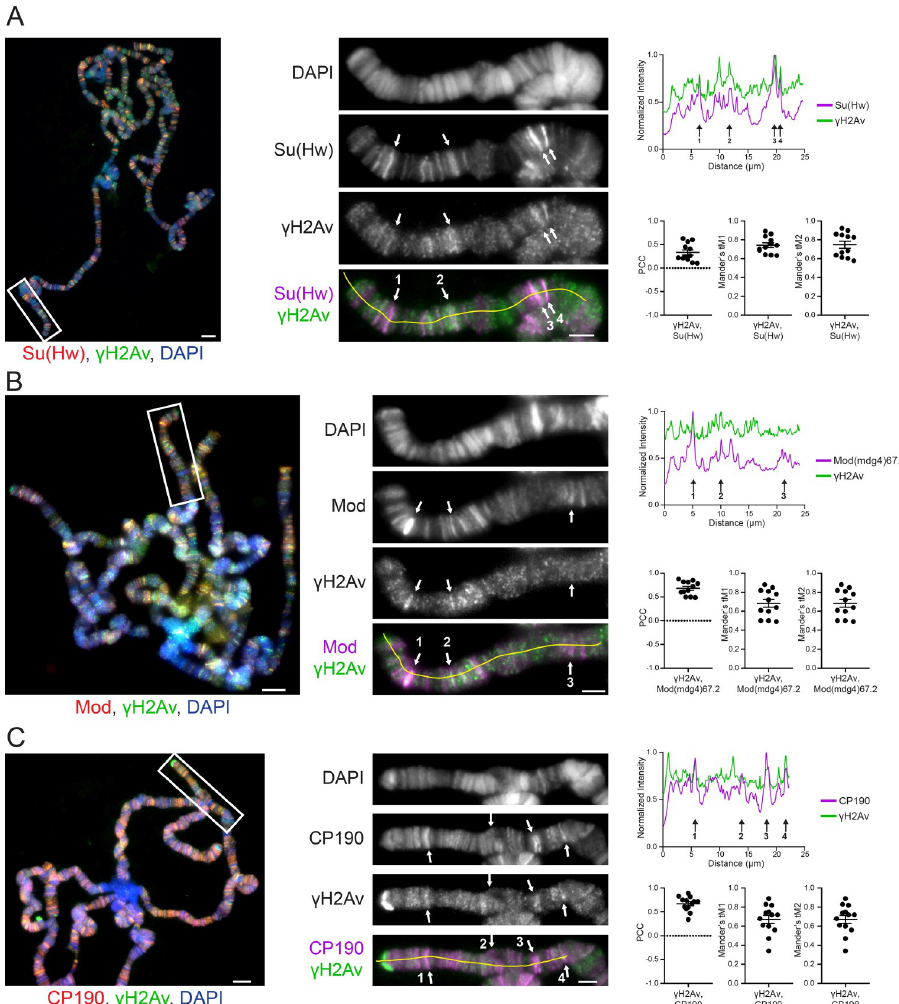
Fig 1. Insulator proteins colocalize with phosphorylated H2Av in Drosophila polytene chromosomes. A . Colocalization of γ H2Av with Su(Hw). B . Colocalization of γ H2Av with Mod(mdg4)67.2. C . Colocalization of γ H2Av with CP190. Immunofluorescent micrographs of polytene chromosome squashes obtained from wandering third- instar larvae are shown on the left. Magnified insets are shown in the middle, corresponding to the white boxes in the figures on the left. Scale bars are 5 μ m in the figures and 2 μ m in the insets. Insets are shown as RGB merge, with DAPI on the blue channel, γ H2Av on the green channel, and various insulator proteins on the red channel. Red and green channels are shown independently in grey scale and merged as magenta and green. On the right are linescans corresponding to the yellow lines in the merged insets. Linescan intensities were normalized by dividing each value by the maximum intensity recorded on each channel. Arrows in the images and respective linescans denote regions of strong colocalization. Pearson’s Correlation Coefficient (PCC) for γ H2Av signal with each insulator protein signal is plotted, with each point representing the polytene genome of each cell. Similarly, Mander’s and tM2 are plotted in each cell. Error bars represent one standard error of the